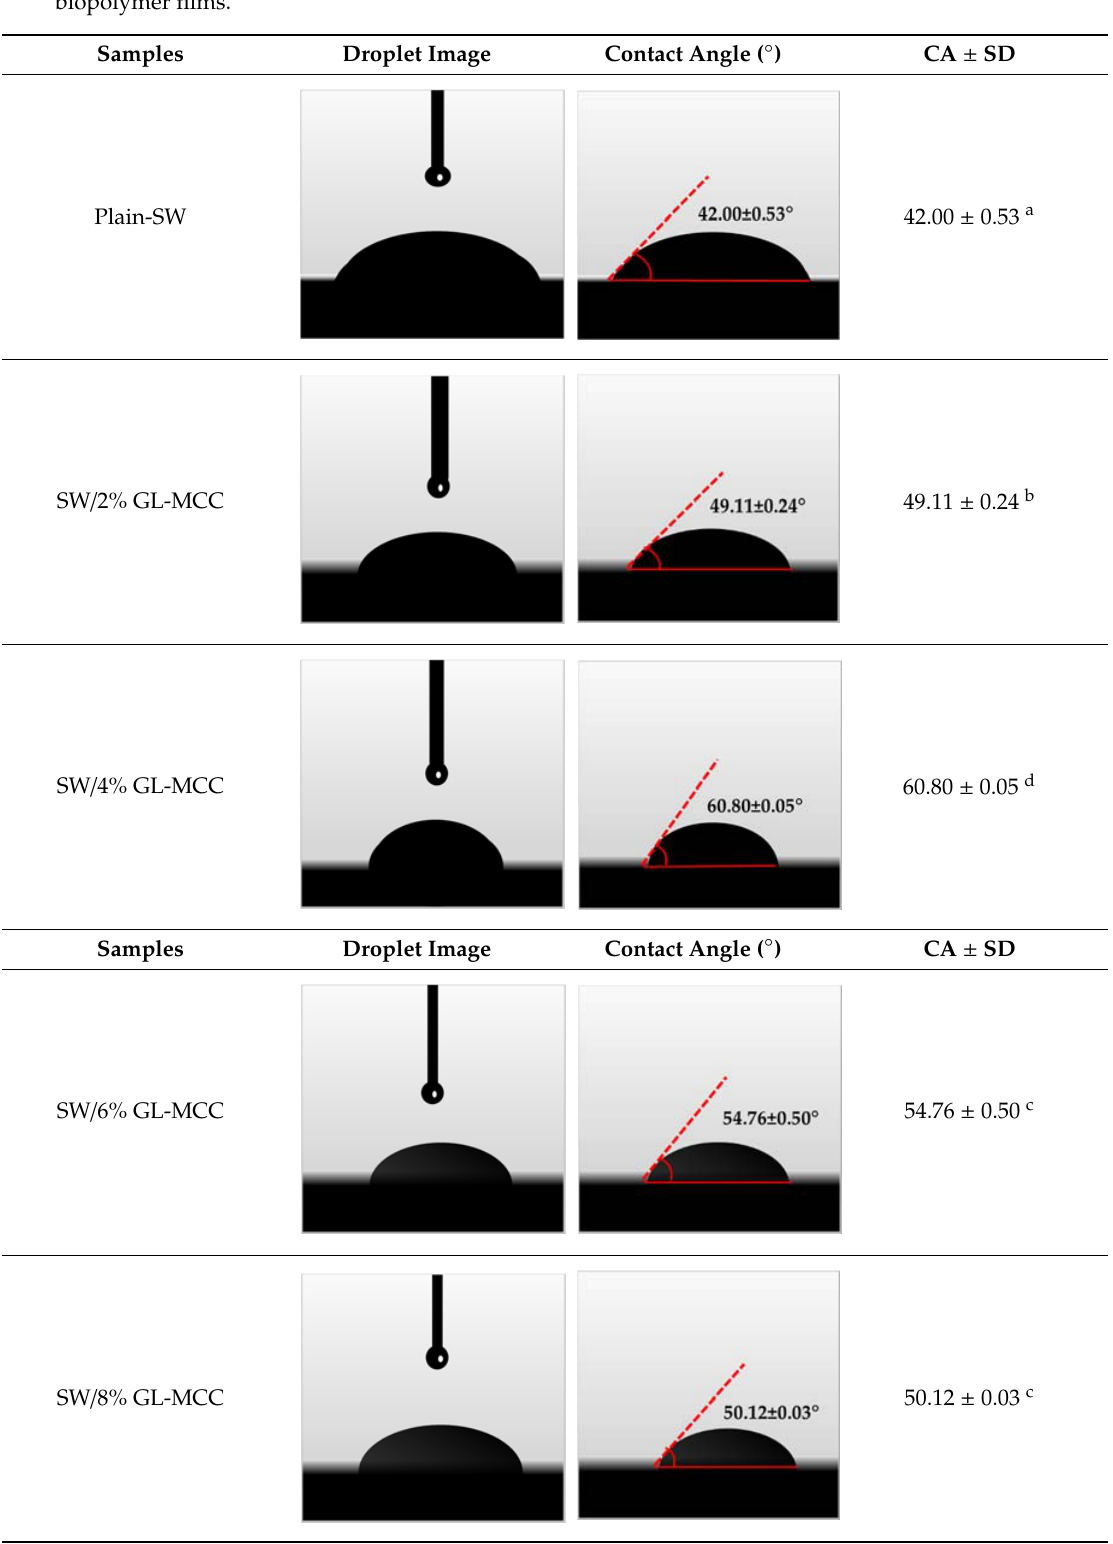
Table 2. Water contact angle (°) of macroalgae (SW)/polysaccharide microfibre (GL-MCC) biopolymer films.